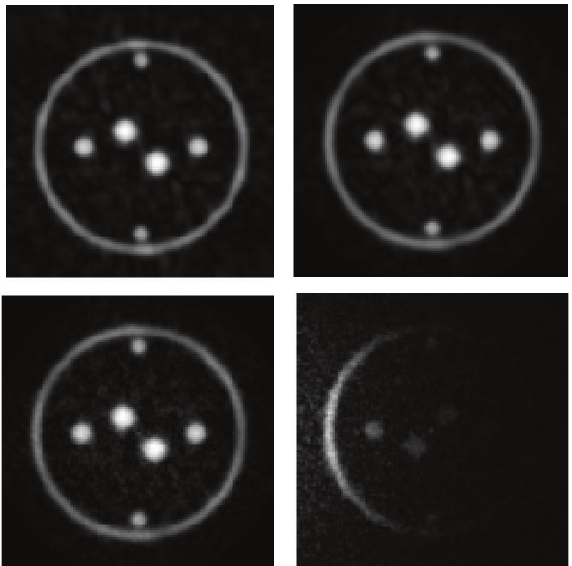
Figure 6: Four identical cross-sections showing, reconstruction with a uniform coil (top left), with 32 dipole coils (top right), with one dipole coil including noise (bottom right), and 32 dipole coils including noise (bottom left).